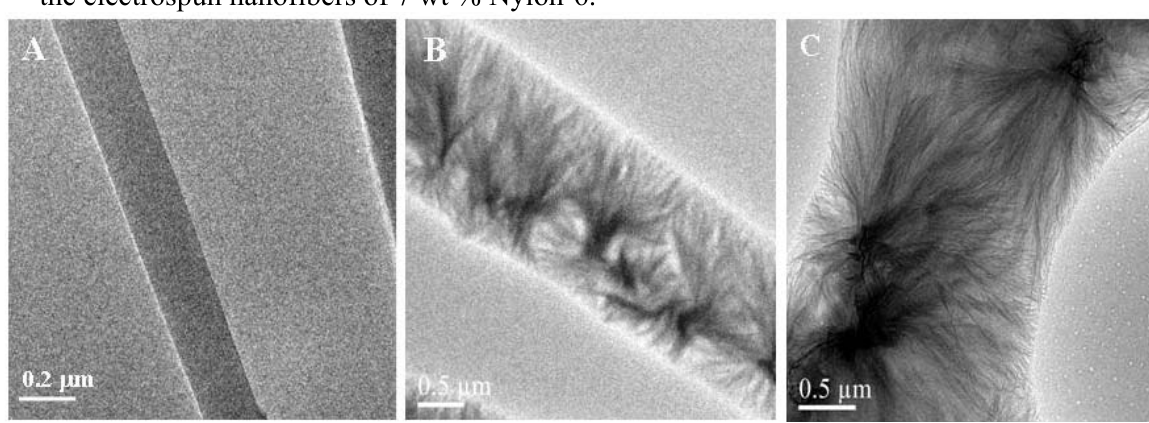
Figure 6. TEM images of (A) neat Nylon-6 nanofibers; (B) and (C) im MWCNTs within the electrospun nanofibers of 7 wt %